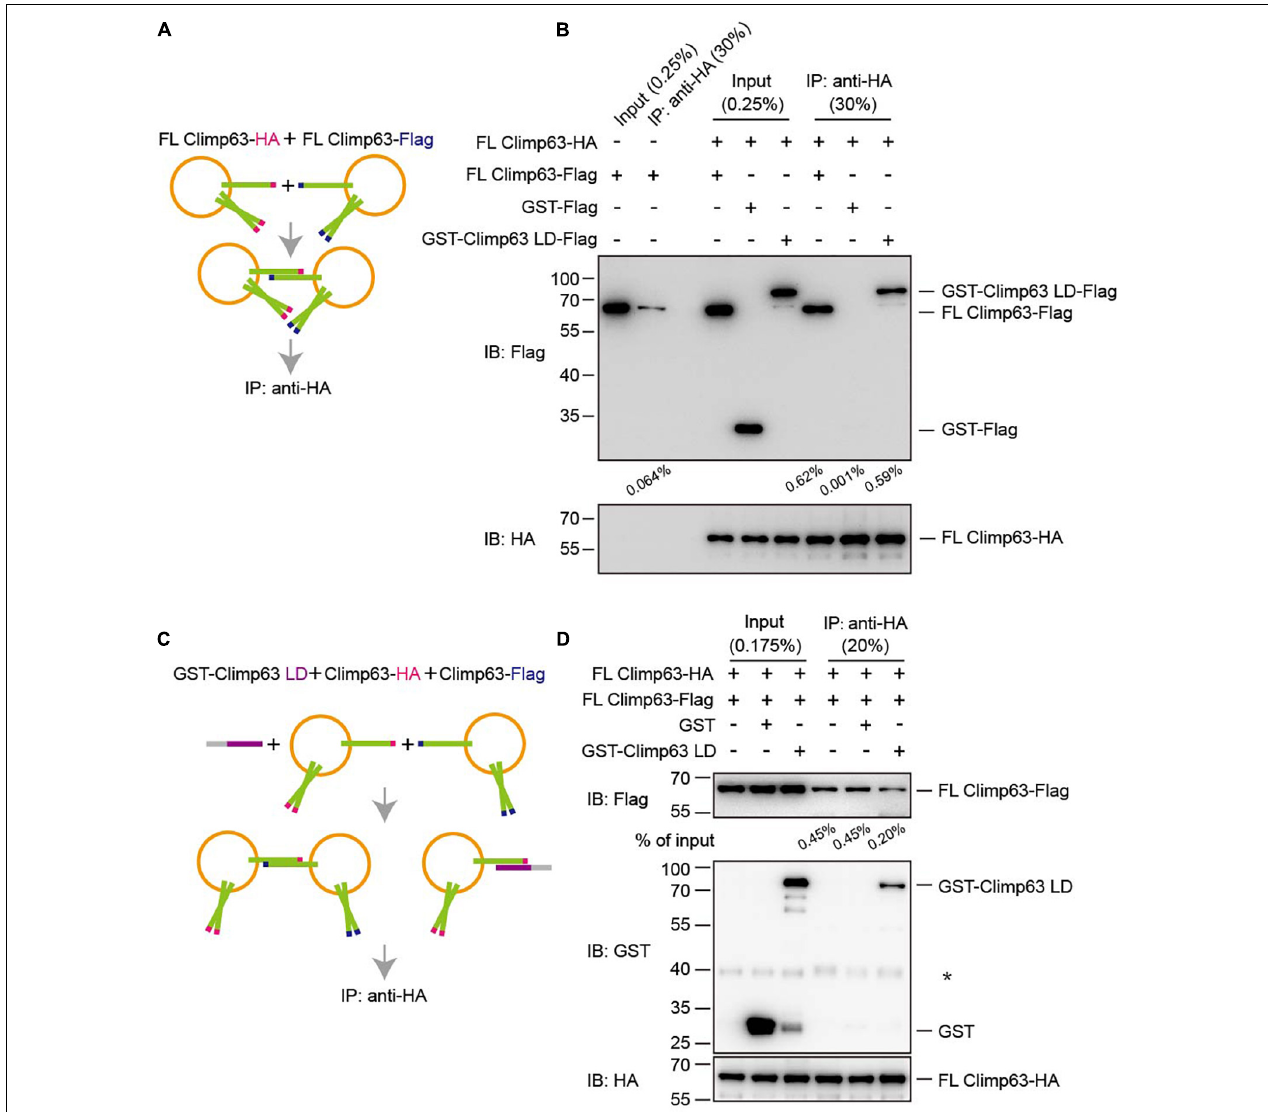
FIGURE 4 | Interactions between reconstituted Climp63. (A) Schematic diagram of the pull-down process shown in (B) . (B) FL Climp63-HA and FL Climp63-Flag were individually reconstituted into proteoliposomes and subjected to flotation. The top fractions (50 µ l of 250 µ l) were used for the pull-down assays. FL Climp63-HA-containing vesicles ( ∼ 0.75 µ g protein, 0.03 µ M) were mixed with the indicated Flag-containing samples, including FL Climp63-Flag-containing vesicles ( ∼ 1.5 µ g protein, 0.06 µ M), GST-Climp63 LD-Flag (1.5 µ g, 0.05 µ M), and GST-Flag (1.5 µ g, 0.15 µ M), and precipitated by anti-HA agarose. The samples were analyzed by immunoblotting using the indicated antibodies. 0.25% of the input and 30% of the precipitate was loaded. The relative levels of co-precipitated Flag-proteins were quantified using the Gel-Pro analyzer software and normalized to the levels of input. Data are representative of three biological repeats. (C) Schematic diagram of the pull-down process shown in (D) . (D) FL Climp63-HA and FL Climp63-Flag were individually reconstituted into proteoliposomes. FL Climp63-HA-containing vesicles ( ∼ 0.1 µ M) were mixed with FL Climp63-Flag-containing vesicles ( ∼ 0.15 µ M). GST-Climp63 LD (0.9 µ M) was added for competition and GST (3 µ M) was used as a control. The samples were analyzed by immunoblotting using the indicated antibodies. 0.175% of the input and 20% of the precipitate was loaded. The relative levels of co-precipitated Flag-proteins were quantified using the Gel-Pro analyzer software and normalized to the levels of input. The asterisk ( ∗ ) indicates a non-specific band. Data are representative of three biological repeats.